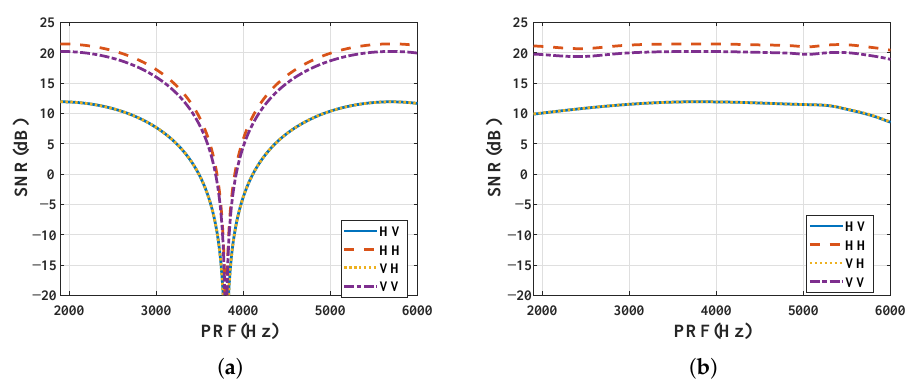
Figure 13. SNR performance curves of system #2 after reconstruction ( a ) via conventional MI method; ( b ) via the proposed JOSA method.